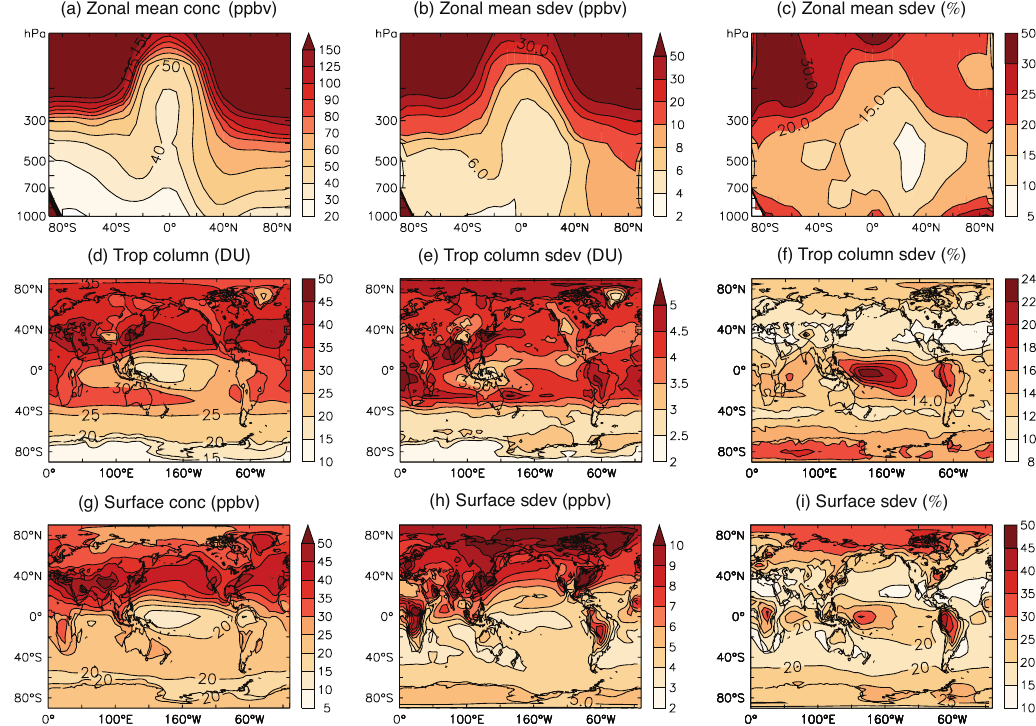
Fig. 3. ACCMIP ensemble mean, annual mean ozone climatologies and their inter-model variability, for the 2000 time slice of the Historical simulation. Top row shows zonal mean ozone, the middle row shows the tropospheric ozone column, and the bottom row shows surface ozone. For each row, the left hand panels show the absolute values of the ozone variable: ppbv for the zonal mean and surface concentrations, and Dobson units (DU) for the tropospheric column. The middle panels show the absolute standard deviations in the same units. The right hand column expresses the standard deviation as a percentage of the ensemble mean value (also known as the coefficient of variation). Note that each panel has a different scale.